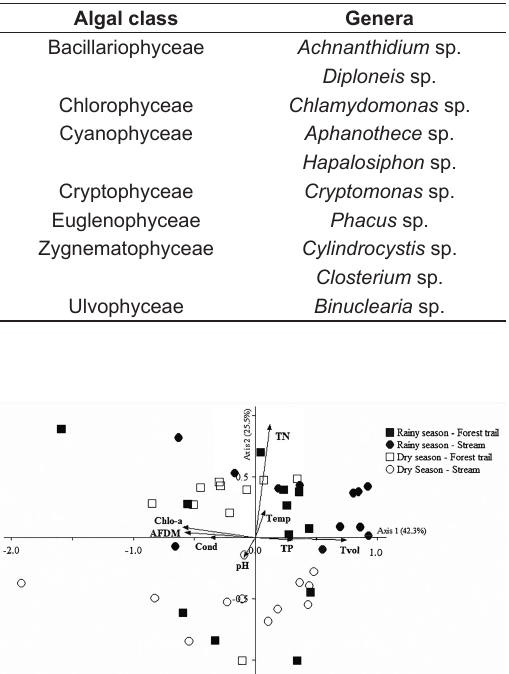
Table 2. List of algae genera and their respective groups identified in the phytotelma of Nidularium longiflorum .